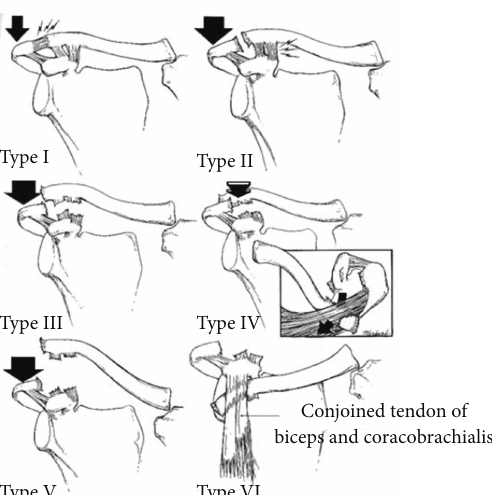
Figure 1: Rockwood’s classification of the acromioclavicular joint injuries. (Reproduced from Bucholz RW, Heckman JD, Rockwood AJ, and Rockwood and Green’s Fractures in Adults, vol. 1. Philadel- phia: Lippincott Williams & Wilkins, 1991).